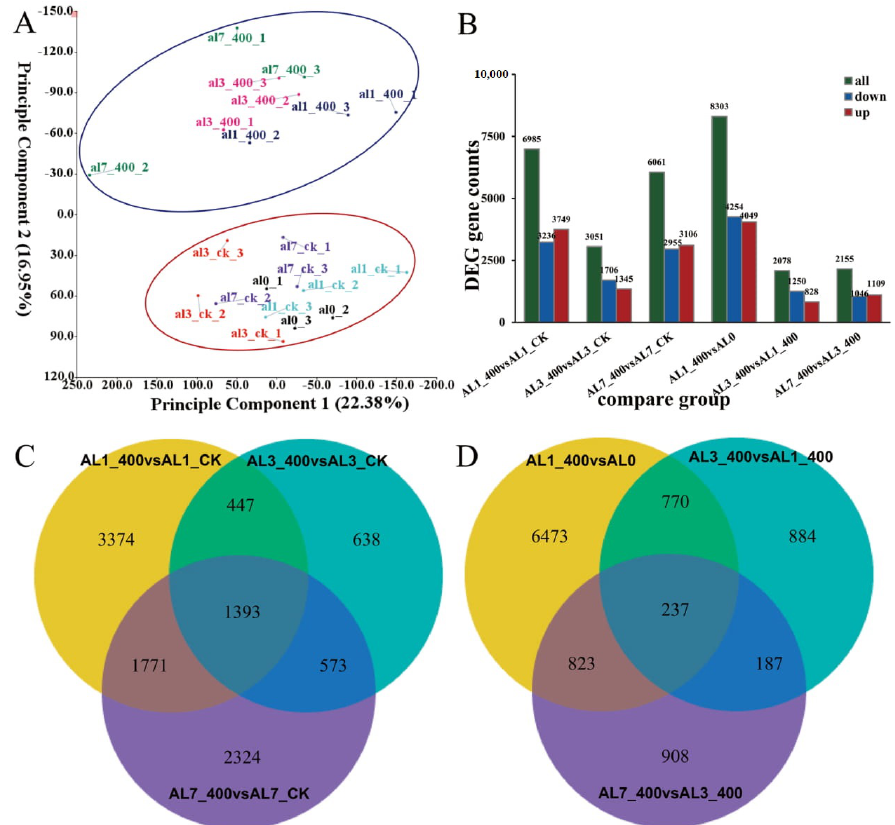
Figure 6. The DEGs of N.cadamba in response to aluminum stress. ( A ) Principal component analysis (PCA) of DEGs: diagram of treatment group and control group at 0 days, 1 day, 3 days, 7 days, the dots with the same color represent 3 biological replicates of the same treatment group, the blue area and the red area are the treatment group and control group gene cluster, respectively. ( B ) The green bar represents all DEGs, downregulated DEGs are in blue, and upregulated DEGs are in red, FDR < 0.05. ( C , D ) The overlapping area represents the DEGs with a common regulation mode between different treatments.